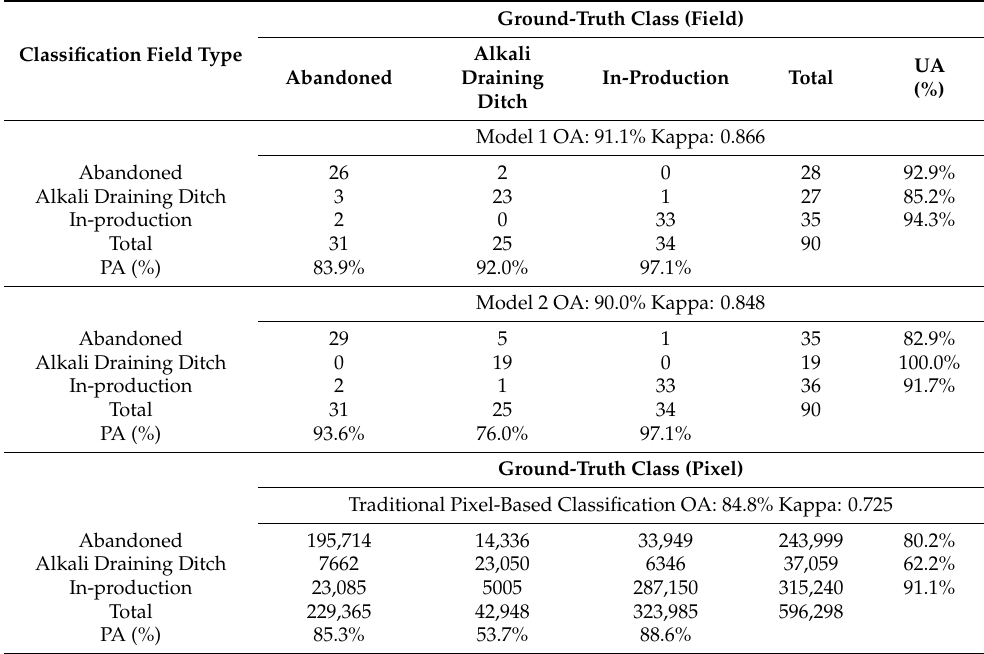
Table 5. Confusion matrices generated by classification Models 1 and 2 for the validation